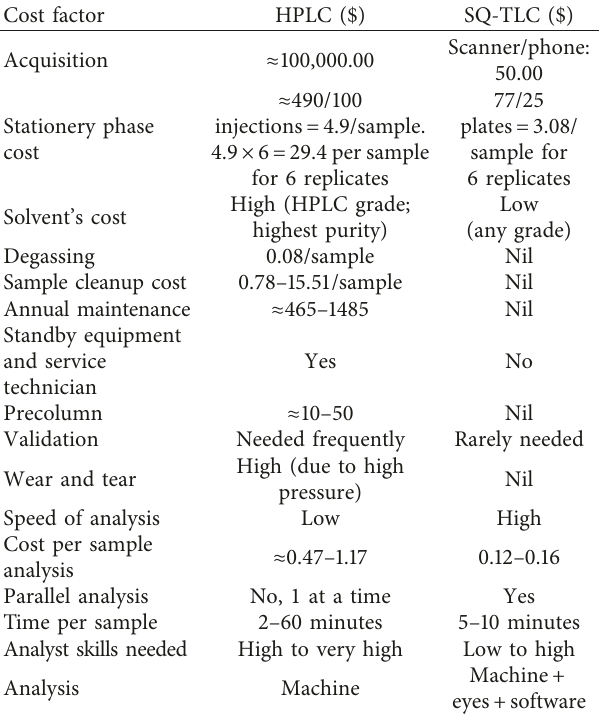
Table 5: An estimated comparison of the cost drivers for HPLC and SQ-TLC